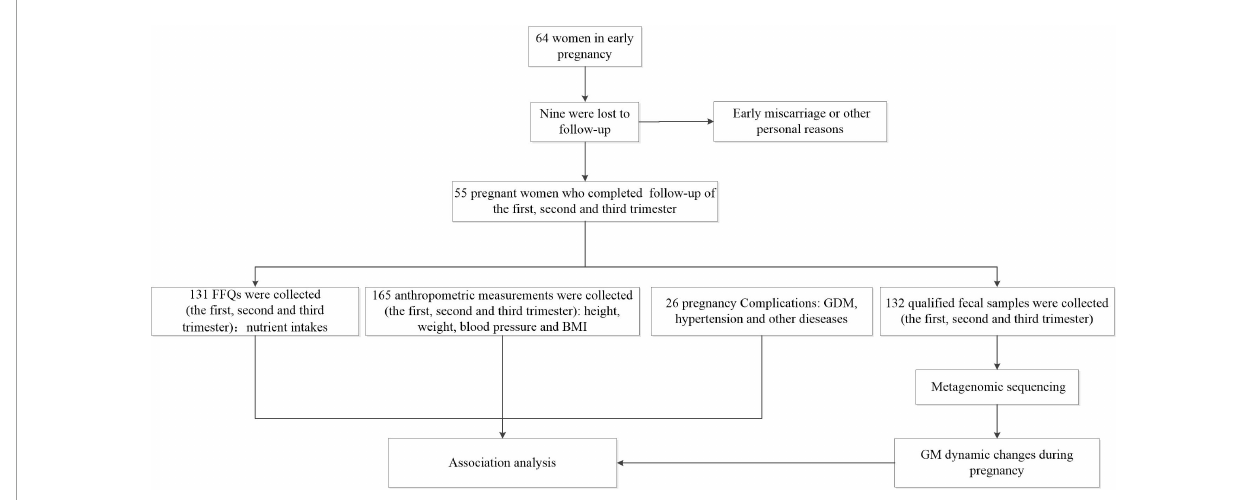
FIGURE1 Procedures regarding of basic information and sample collection in the present study.